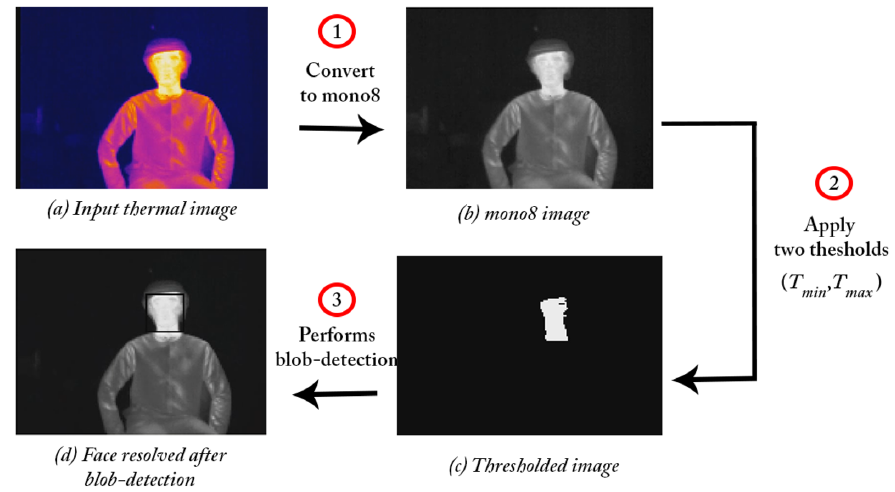
Figure 4. Demonstration of thermal detection using the Optris